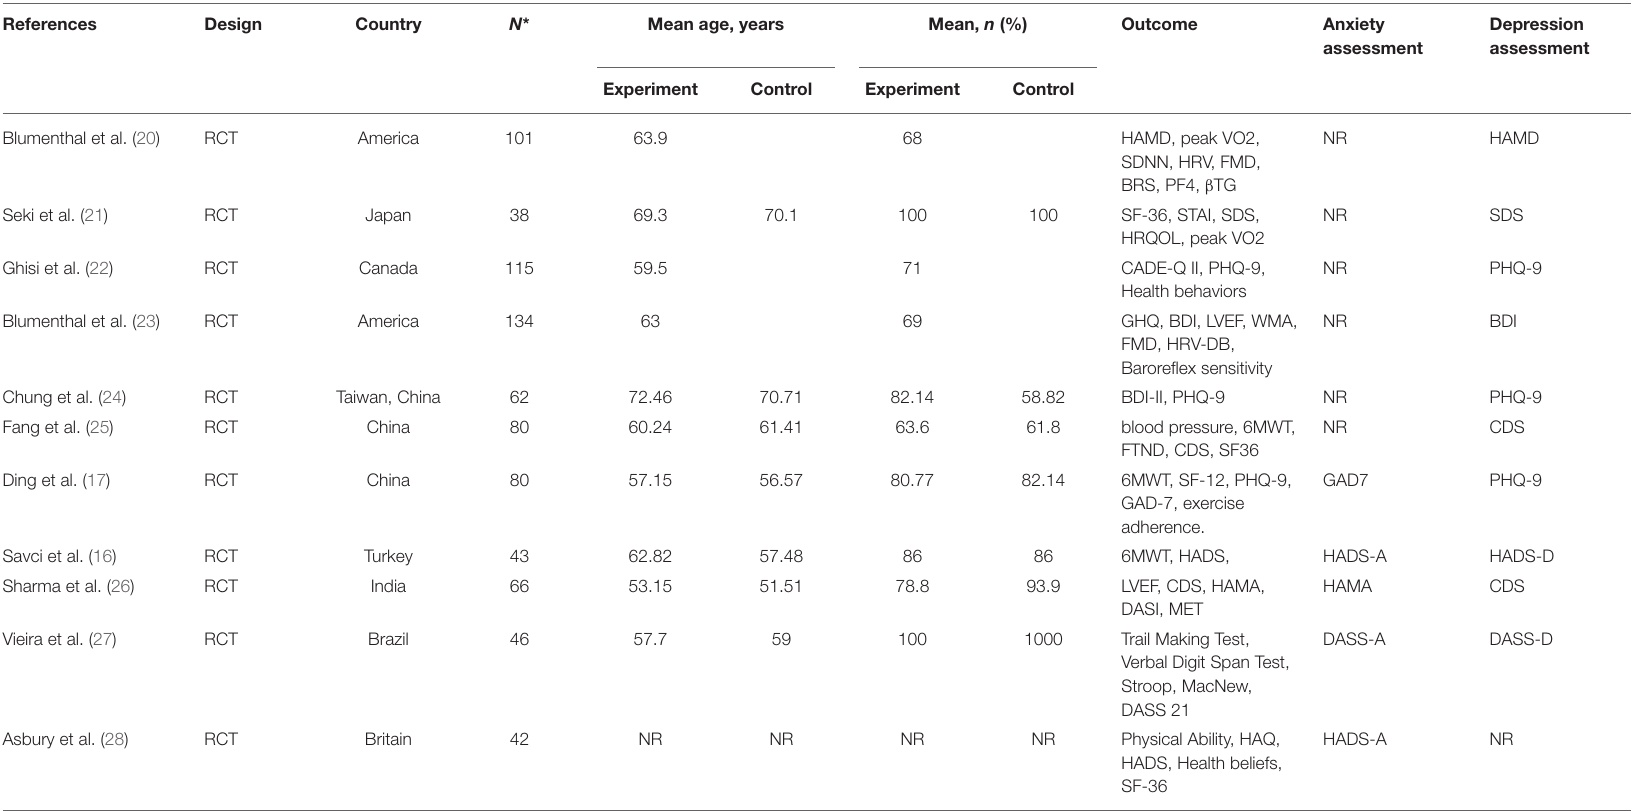
TABLE 1 | Characteristics of included